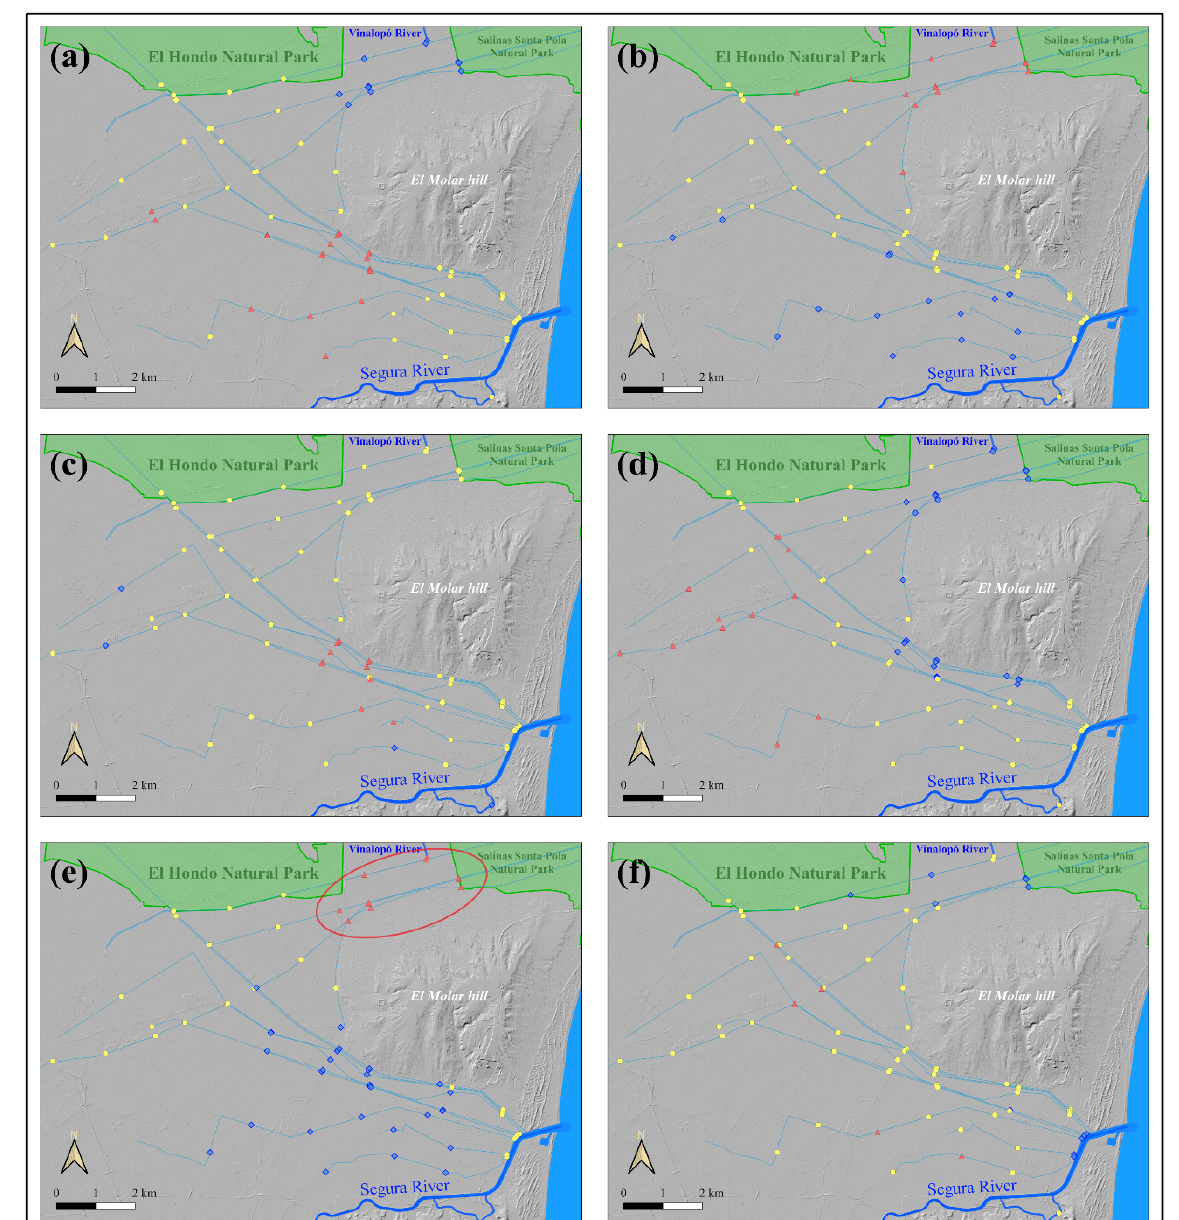
Figure 2. Getis–Ord (𝐺 (cid:3036)∗ ) statistic results for: ( a ) pH; ( b ) EC; ( c ) TSS; ( d ) nitrates; ( e ) DDT–DDE; and ( f ) glyphosate. Red triangles represent high–high clusters (hotspots), blue circles represent low–low clusters (cold spots), and yellow dots represent non-significant points. The hotspot area of DDT is highlighted with a red ellipse ( e ). The categorization of the points obtained from the Getis–Ord (𝐺 (cid:3036)∗ ) statistic (i.e., high–high, low–low, non-significant) was incorporated into the database of the water parameters and used as factors for a Kruskal–Wallis test (Table 3) [33], which could be associated with significant differences between clusters. Besides, box-plots for each parameter were also computed (Figure 3). Significance letters from Dunn’s test ( p < 0.05) are included in the boxplots.